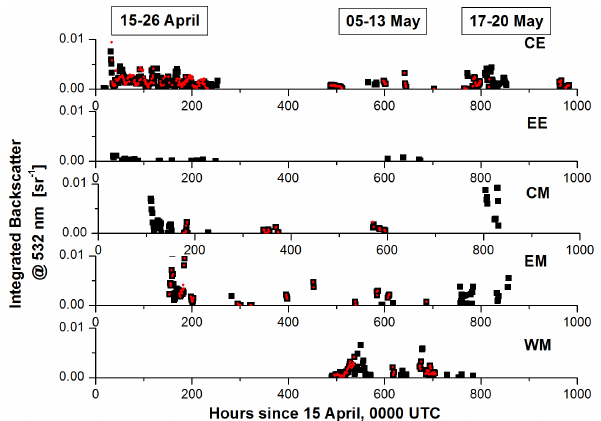
Fig. 10. Integrated Backscatter at 532nm measured by EARLINET in the volcanic layers over the 5 clusters: Central Europe (CE), East- ern Europe (EE), Central Mediterranean (CM), Eastern Mediter- ranean (EM), and Western Mediterranean (WM). Mean values ob- served over the cluster are reported as black squares. Values mea- sured at representative site for each cluster are reported as red dots: Hamburg, Belsk, Naples, Thessaloniki and Evora stations were se- lected as representative because of their large number of backscatter measurements at